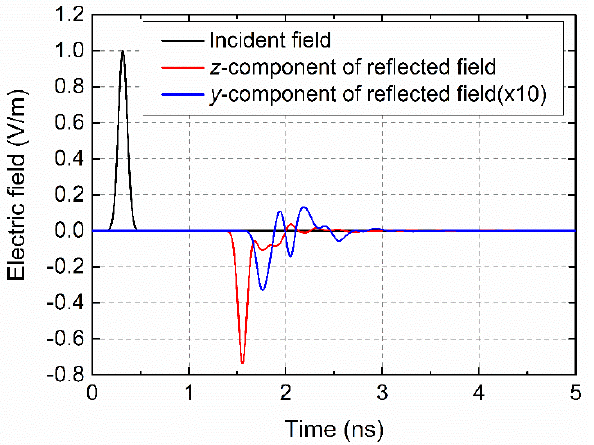
Figure 8. Incident and reflected electric fields at a three-layered carbon-fiber material. The y -oriented reflected field was magnified by a factor of 10.